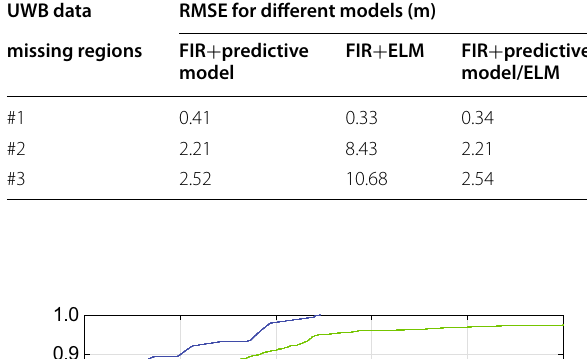
predictive model/ELM in UWB +